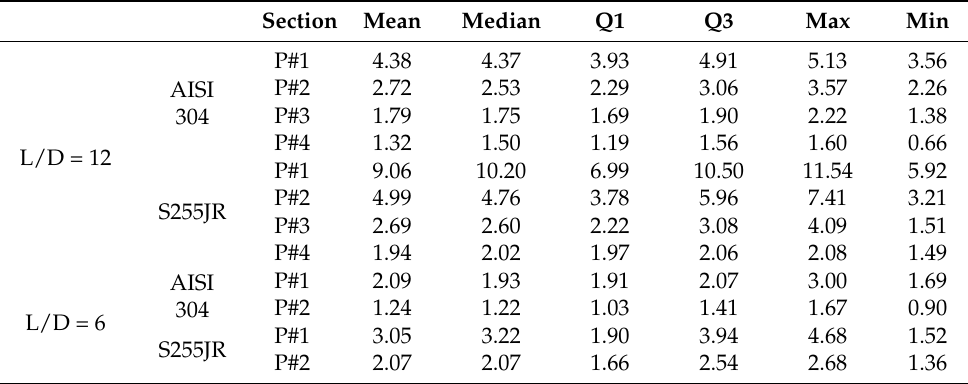
Table 2. Main statistics of the maximum height of the Wz parameter.